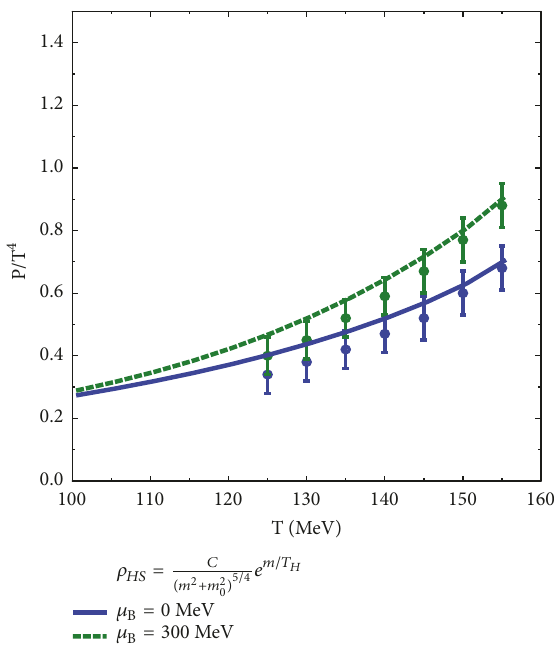
Figure 3: 𝑃/𝑇 4 at zero as well as finitebaryon chemical potential for the Hagedorn spectrum used in [41]. The values of the parameters are also the same as in [41].